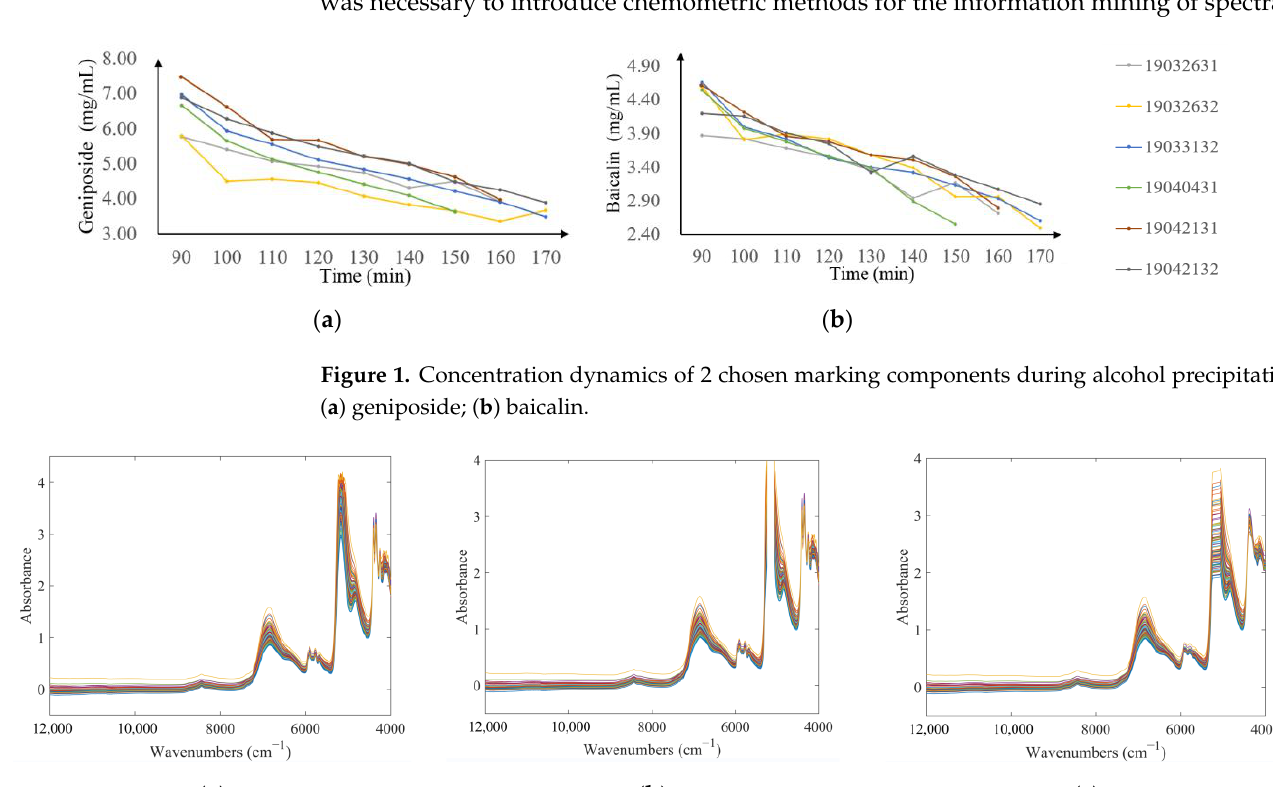
Figure 1. Concentration dynamics of 2 chosen marking components during alcohol precipitation.